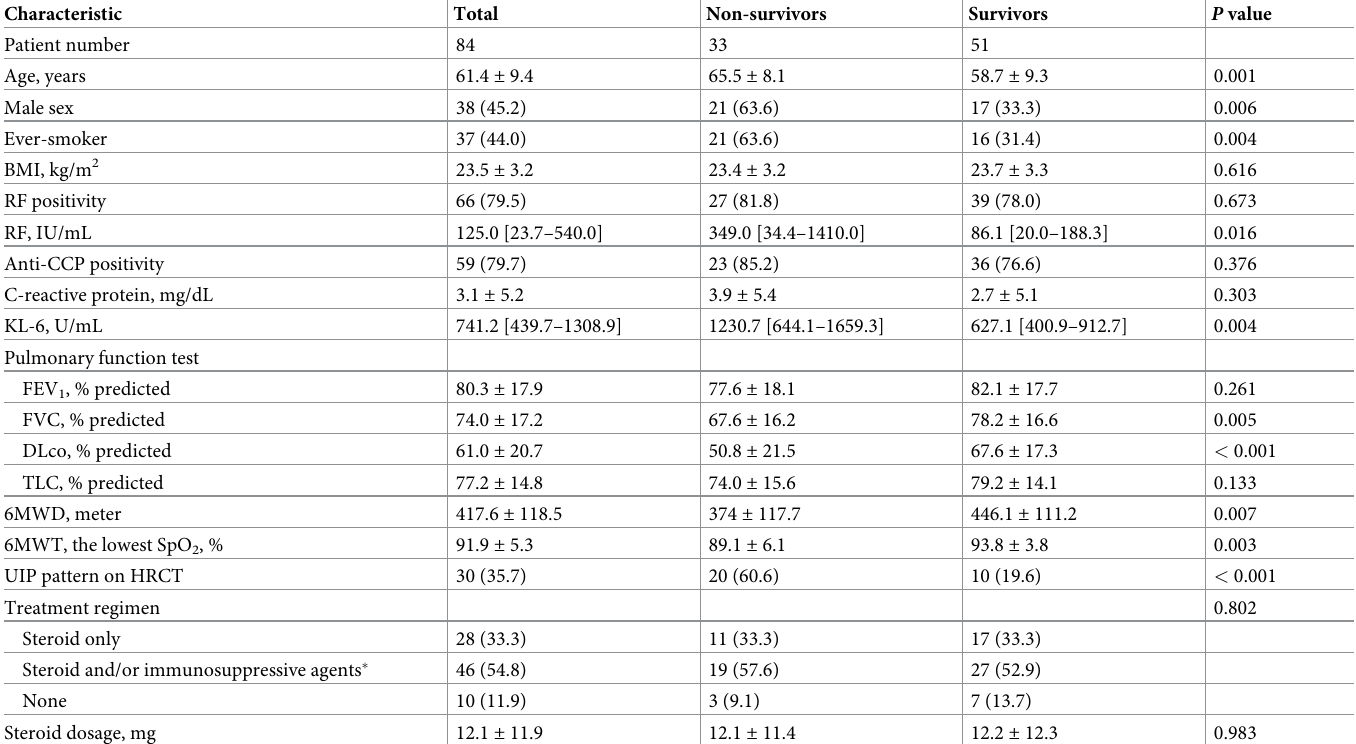
Table 3. Comparison of baseline characteristics between non-survivors and survivors among patients with RA-ILD.